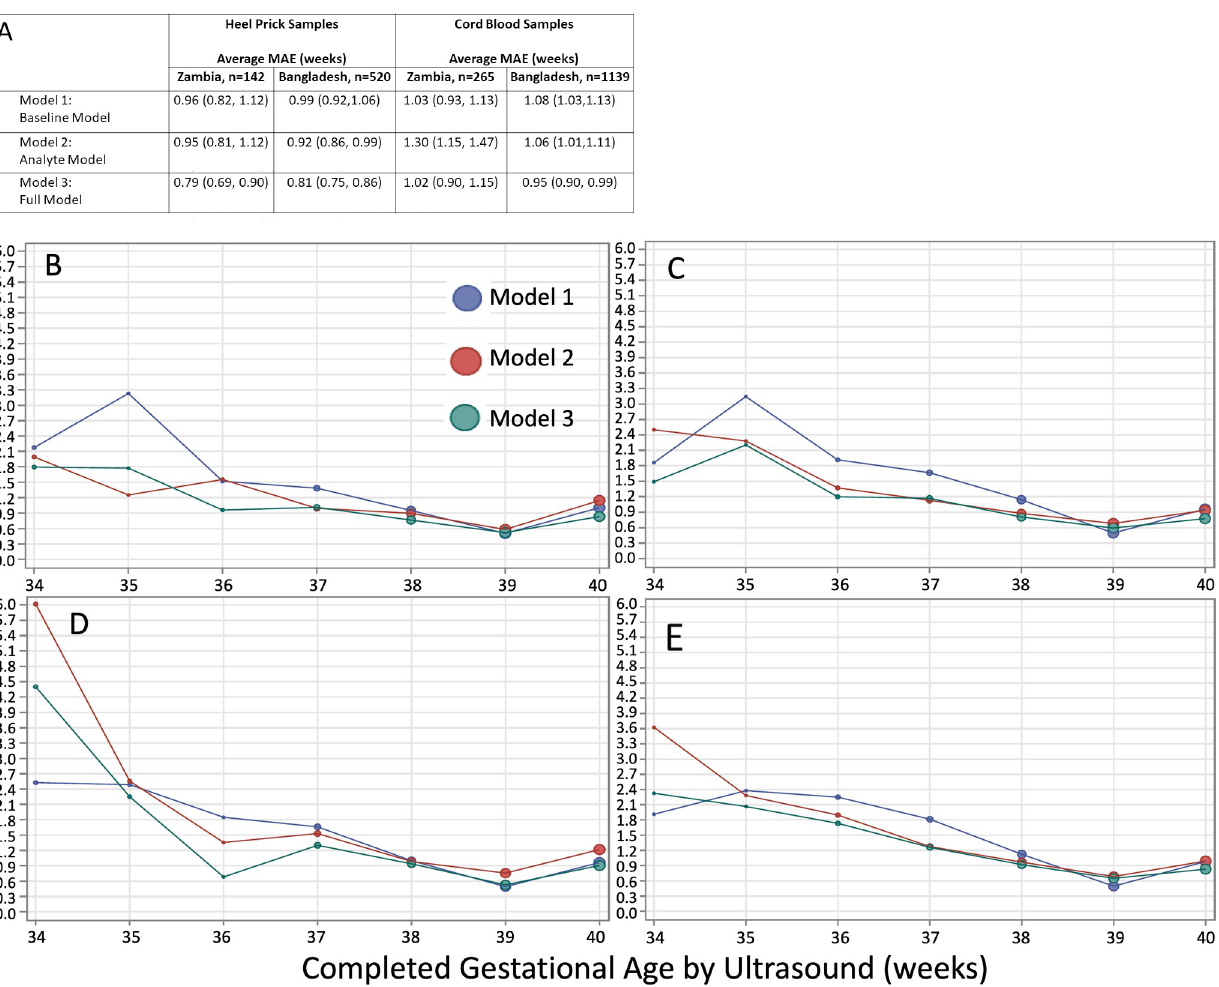
Fig 2. Agreement between algorithmic gestational age estimations compared to ultrasound-assigned gestational age. (A) Legend, and overall MAE (95% CI) for heel prick sample and cord blood samples from Zambia and Bangladesh across three models. Dot size in plots is proportional to sample size in each gestational age category. Performance of each model by ultrasound-validated gestational age when applied to heel prick data in (B) Zambia (C) Bangladesh, and cord blood data in (D) Zambia (E) Bangladesh. MAE, mean absolute error (average absolute deviation of observed vs. predicted gestational age in